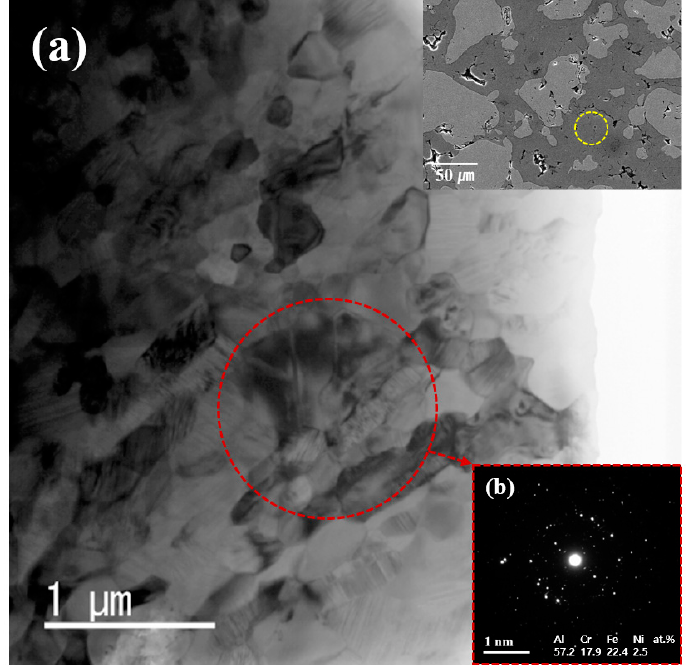
Figure 8. TEM micrographs of the intermetallic compounds region indicated by the yellow circle in inserted Figure 6 and ( b ) Electron diffraction patterns of the region in the red circle in ( a ).